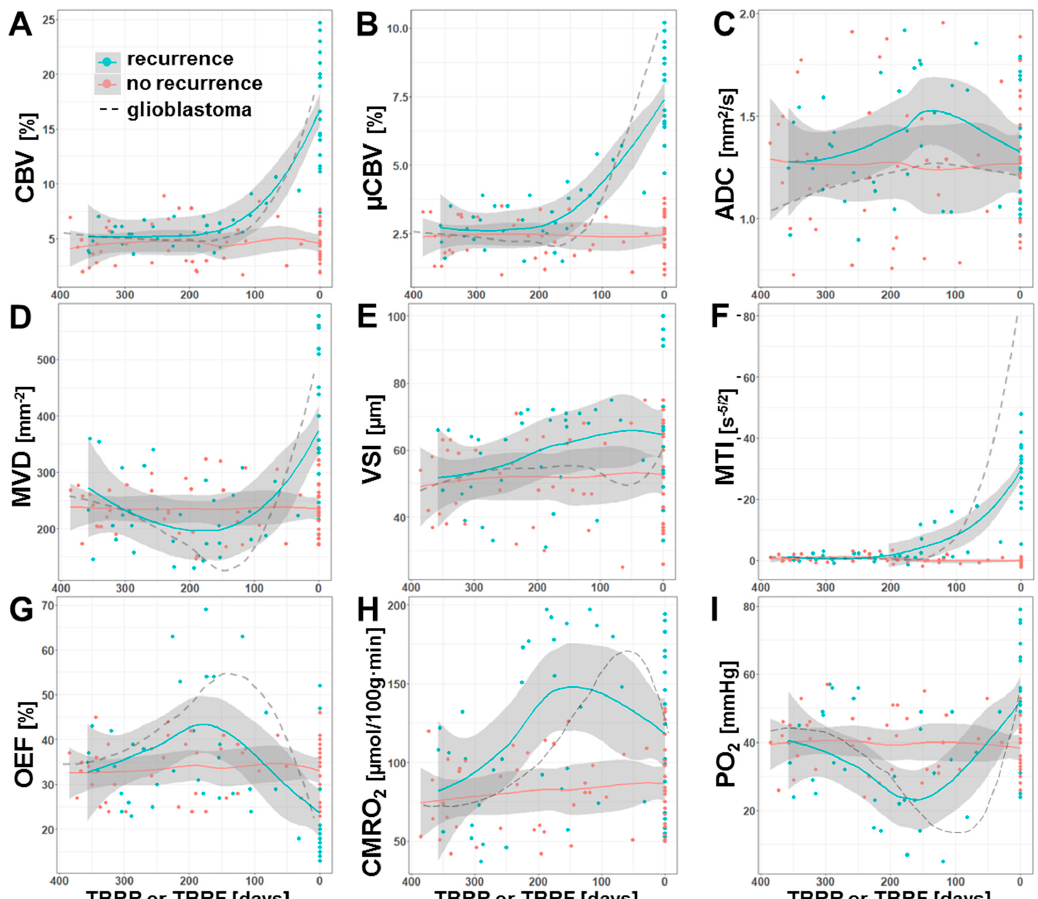
Figure 5. Time courses of the dynamic MRI biomarker changes that occurred prior to recurrence of an AG (cyan) or during a one-year-period without signs of recurrence (red), respectively. Scatter plots and locally-estimated-scatterplot-smoothing (LOESS) trend lines of MRI biomarker for ( A ) macrovascular perfusion (CBV), ( B ) microvascular perfusion (µCBV), ( C ) microstructural density (ADC), microvascular architecture represented by ( D ) microvessel density (MVD) and ( E ) diameter (VSI), ( F ) neovascularization activity (MTI), and oxygen metabolism ( G : OEF; H : CMRO 2 , and I : PO 2 ) versus time before radiological recurrence (TBRR, in days) in case of recurrence or versus time before most recent follow-up examination (TBRF, in days) in case of stable disease (no recurrence). The dashed lines, which are included for comparison purposes, represent the corresponding time courses for isocitrate-dehydrogenase (IDH)-wild type glioblastoma from a previous study [42].